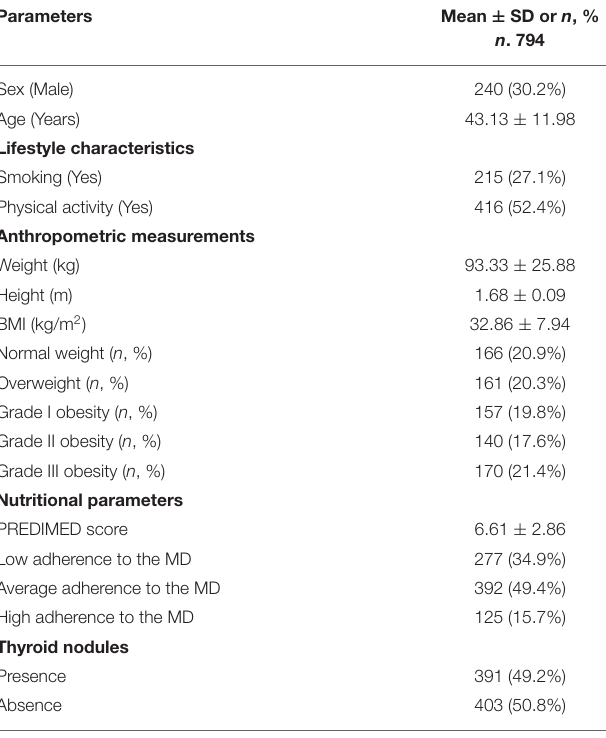
TABLE 1 | The descriptive characteristics, including gender, age, lifestyle characteristics, anthropometric measurements, nutritional, and thyroid parameters of the study population.